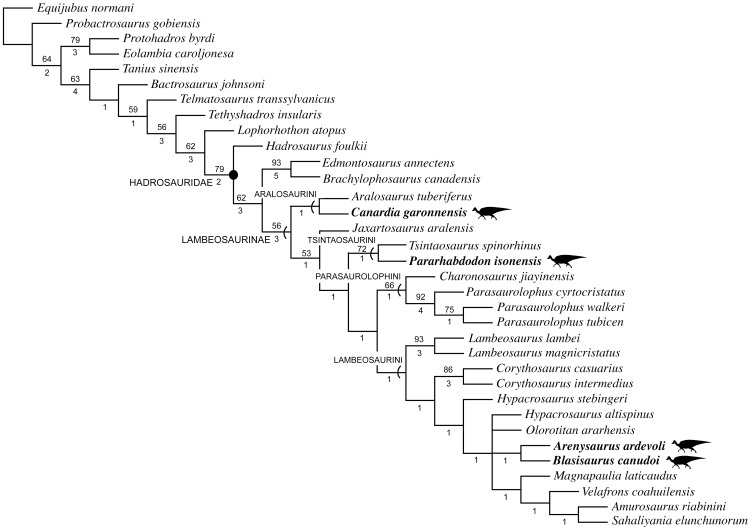
Phylogenetic relationships of lambeosaurine taxa from the European Archipelago.Consensus tree of the five most parsimonious trees resulting from maximum parsimony analysis. The numbers above the branches represent bootstrap frequencies, whereas those below are decay indices (Bremer support).